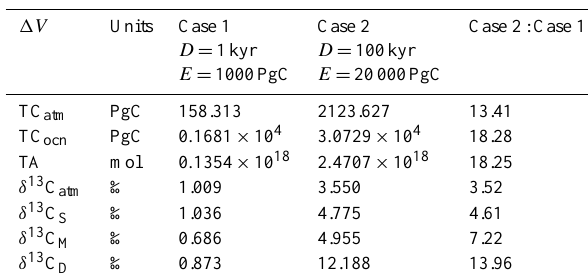
Table 1. Comparison of